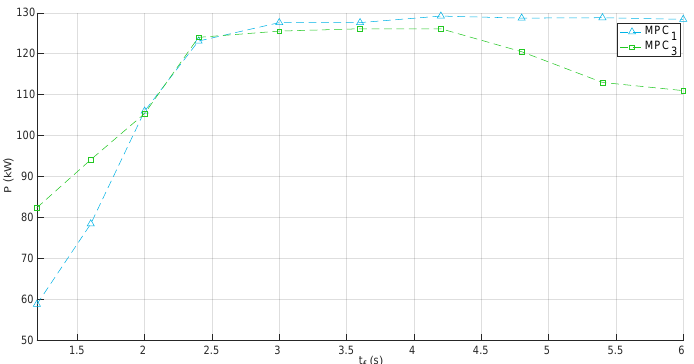
Figure 8. Variation of the extracted mechanical power as a function of the prediction time for MPC 1 and MPC 3 (control parameters listed in Table